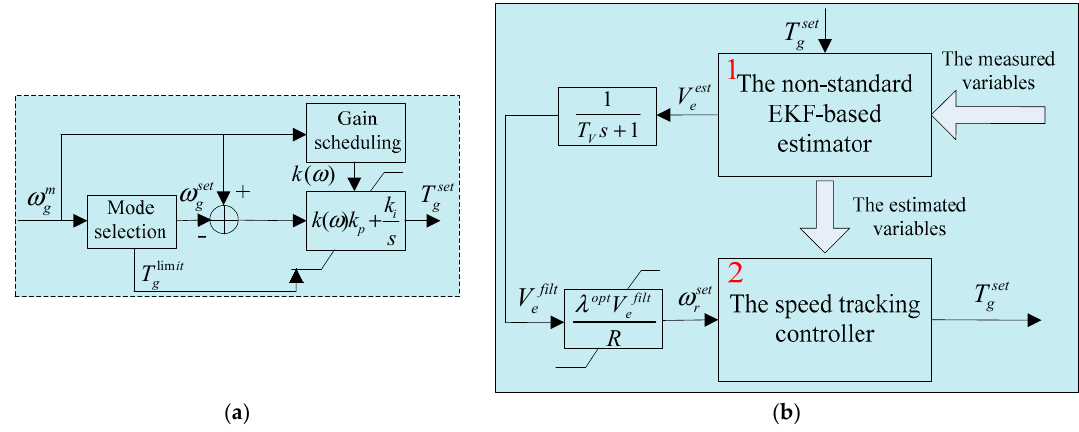
Figure 3. The two MPPT control structures: ( a ) the OT-based controller; and ( b ) the TSR-based controller.